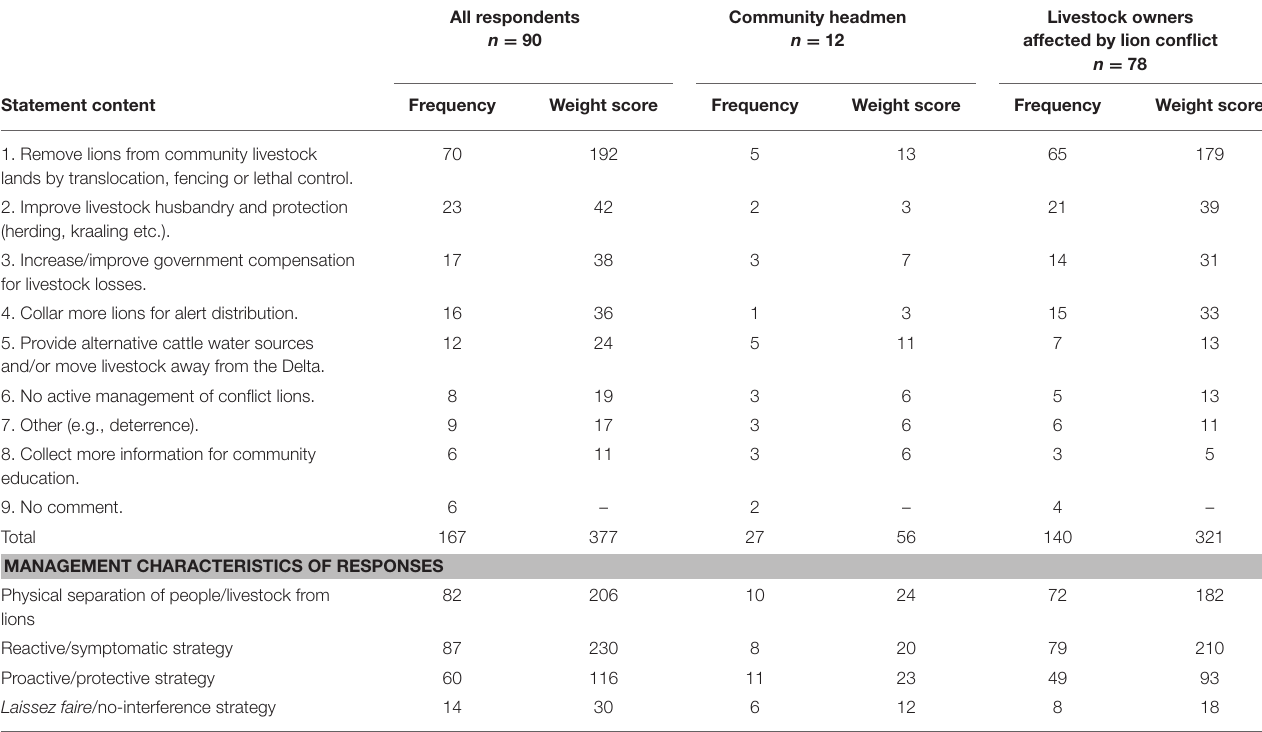
TABLE 3 | Community conflict lion management suggestions during the pilot